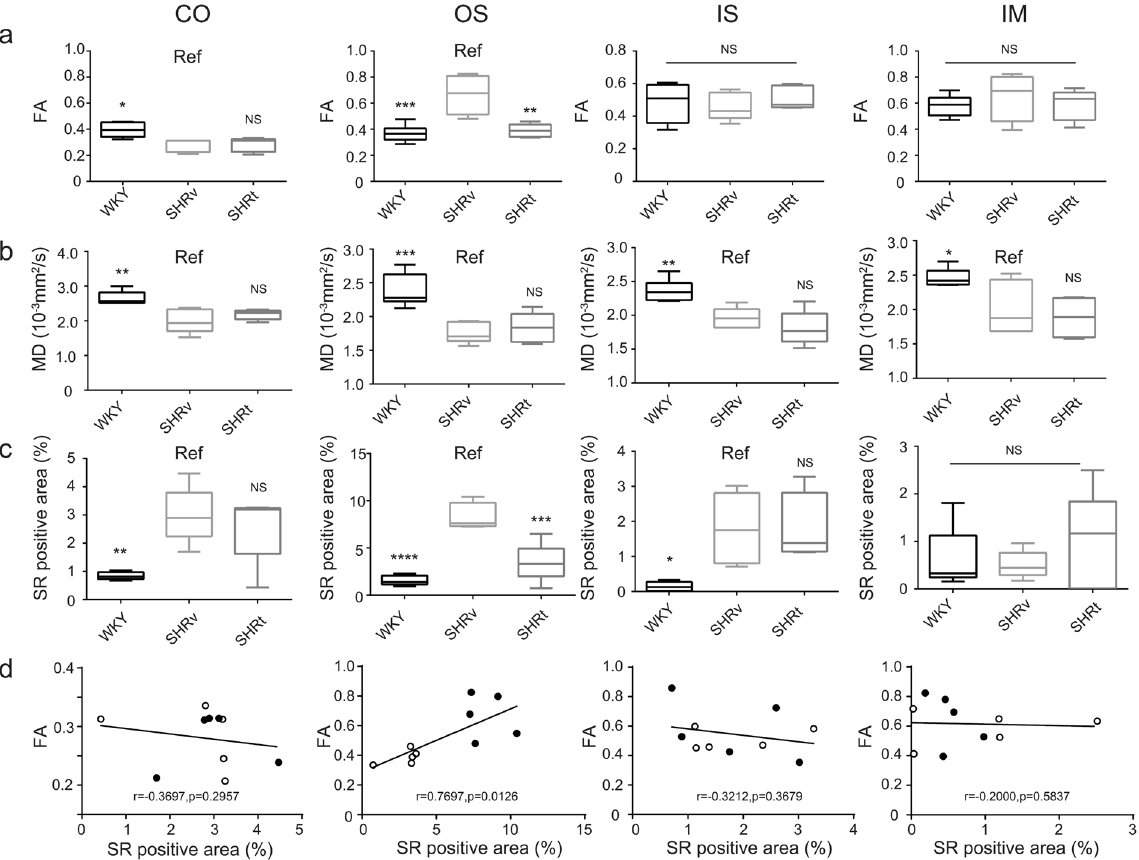
Figure 4. Quantification of FA, MD values, and RF. ( a – c ) Quantification of FA ( a ), MD values ( b ), and RF measured by Sirius Red (SR) staining ( c ) in the CO, OS of outer medulla, IS of outer medulla, and IM of kidneys from WKY rats, SHR/ND rats treated with vehicle (SHRv), and SHR/ND rats treated with telmisartan (SHRt). SHR rats were treated with vehicle vs telmisartan. The data are shown as mean ± SD. * p < 0.05, ** p < 0.01, *** p < 0.001, SHRv vs WKY or SHRt. ( d ) Correlations of FA values with fibrotic areas measured by SR staining based on the data for SHRv and SHRt rat kidneys only. Open circles and closed circles indicate the data from SHRt and SHRv rats